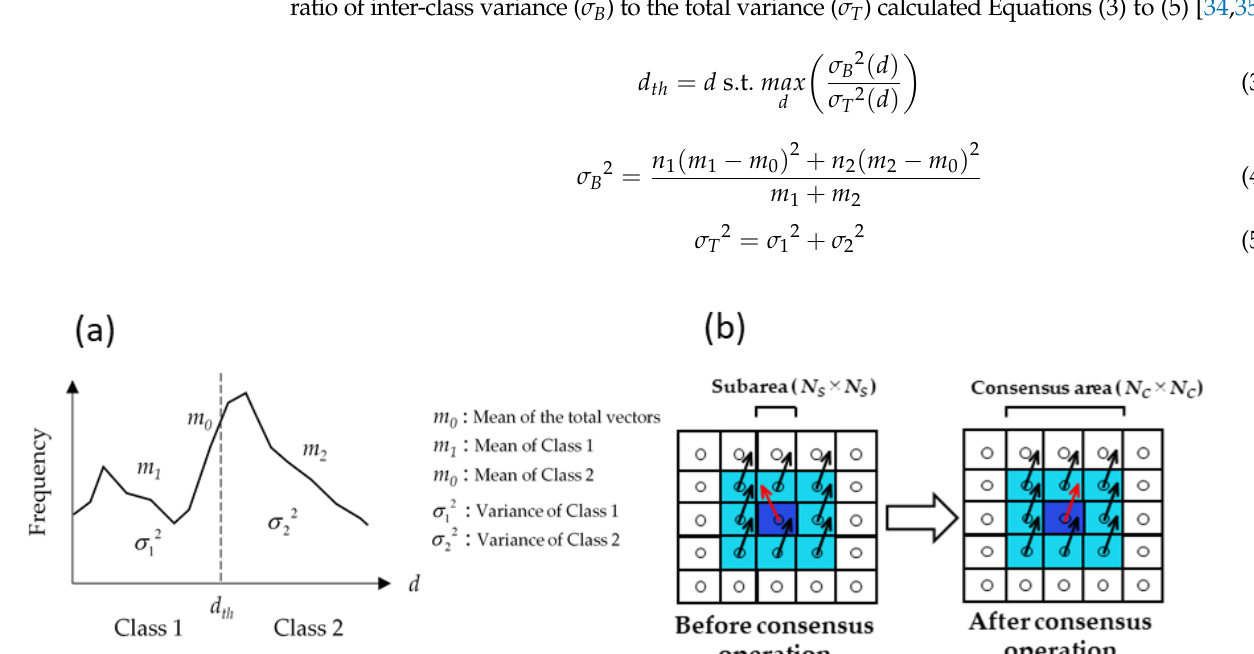
Figure 9. Schematic plan and profile denotes a comparison of DEMs before and after the nonlinear mapping-based geo- metric correction.